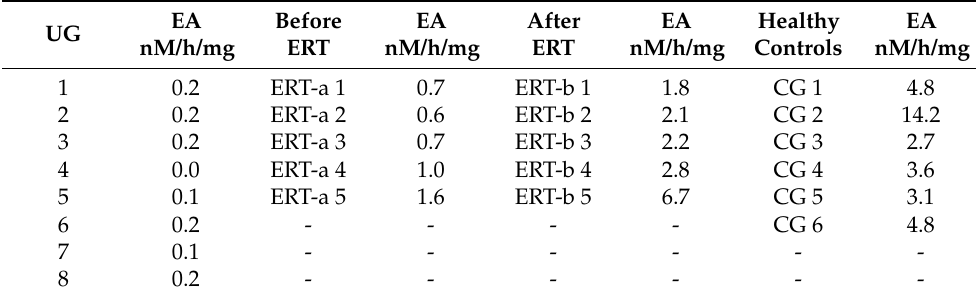
Table 7. Enzymatic activity of